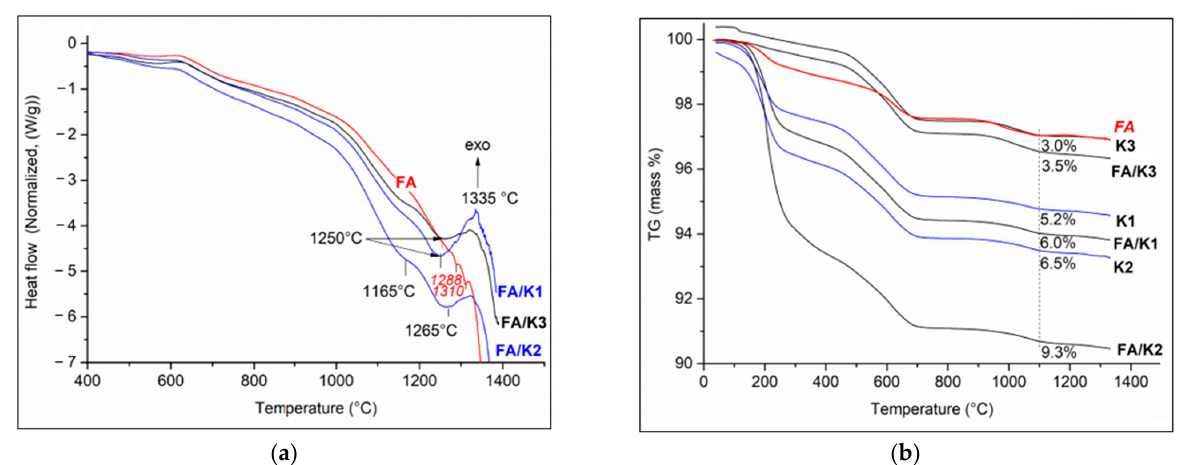
Figure 4. Decomposition of samples on the thermal curves: ( a ) DTA and ( b ) TG.